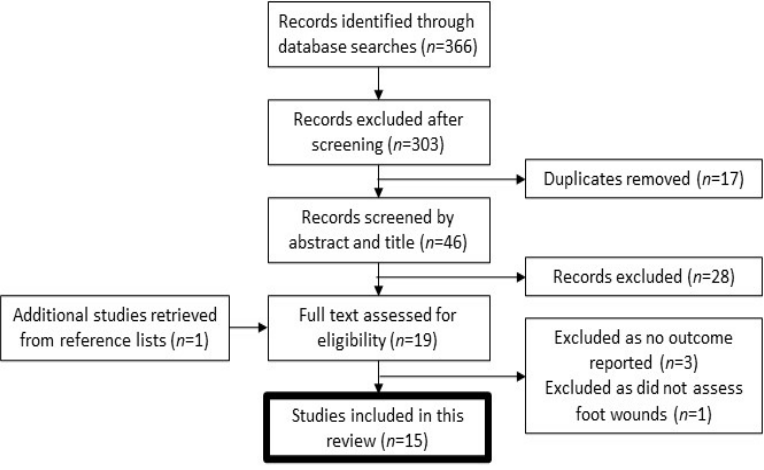
Figure 1. Flow diagram of study selection for the systematic review.